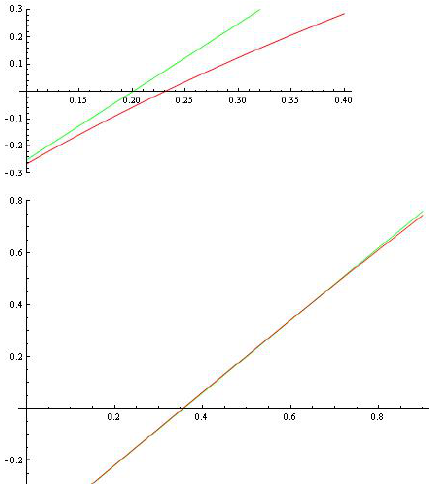
Fig. 1. The functions f ( d ) and g ( d ) for a) β = 1 , q = 0 . 1 ; b) β = 1 , q = 0 . 9 .